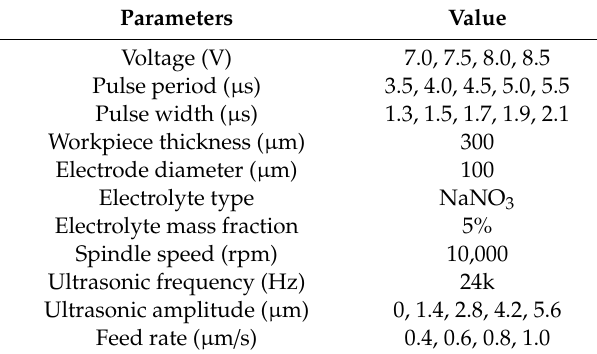
Table 1. Experimental settings.